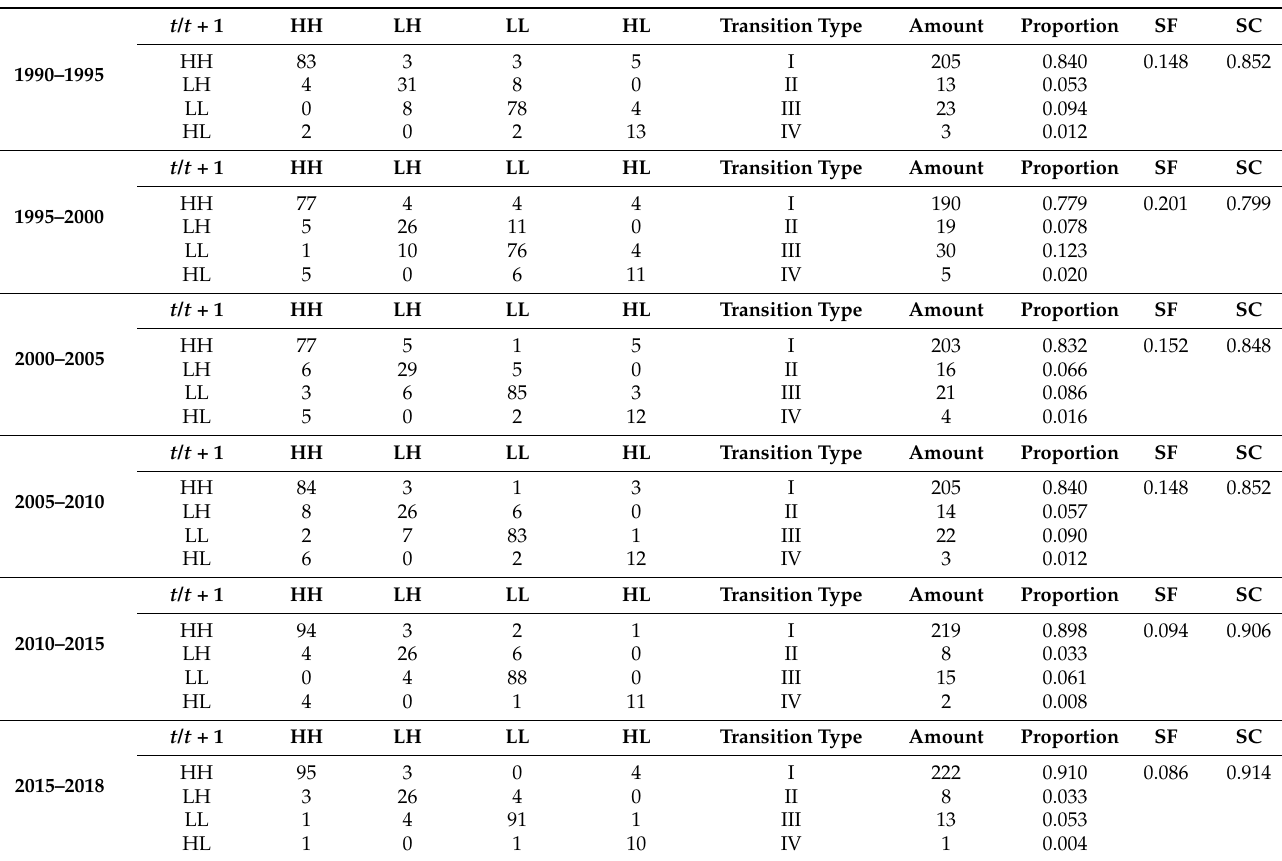
Table 5. Local Moran’s I transition matrix and spatiotemporal transition of ecosystem health at county